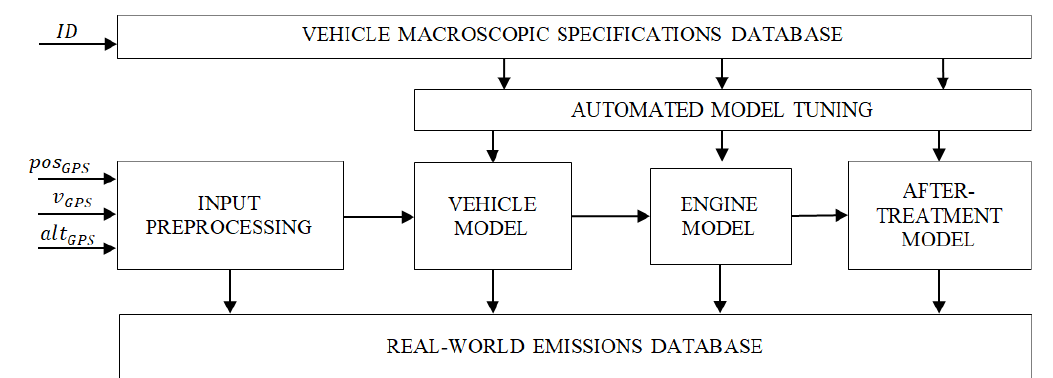
Figure 4. Vehicle pollutant emissions model